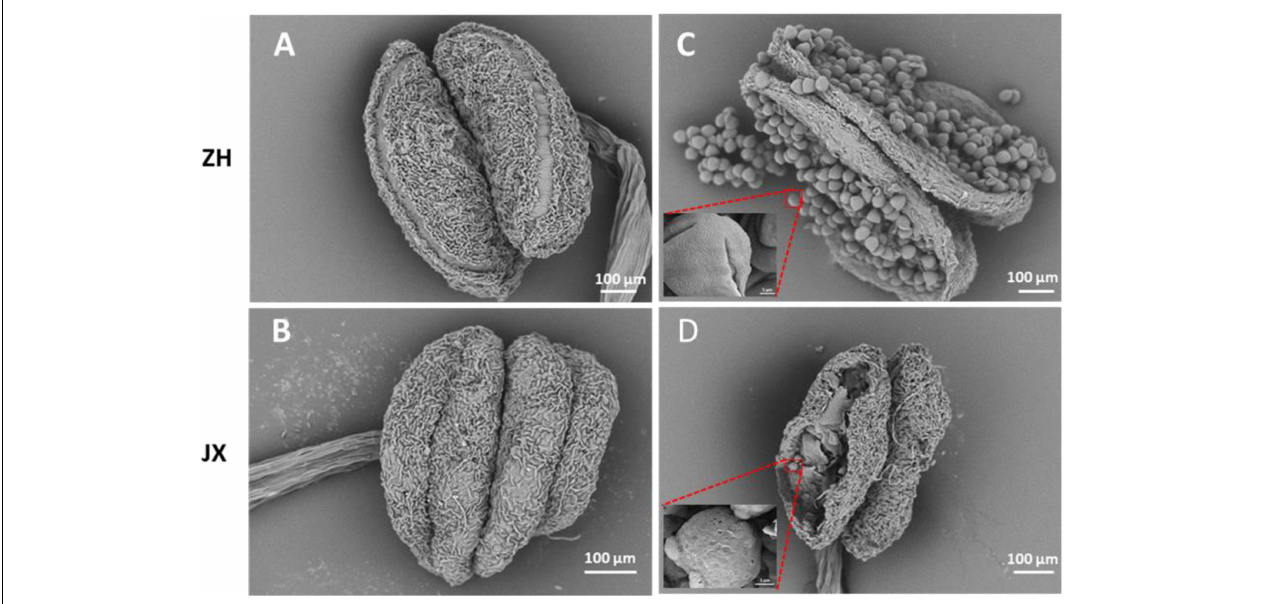
FIGURE 2 | Comparison of anther morphology between “ZH” and “JX” using SEM. (A,B) Anthers before dehiscence. (C,D) Anthers after dehiscence.